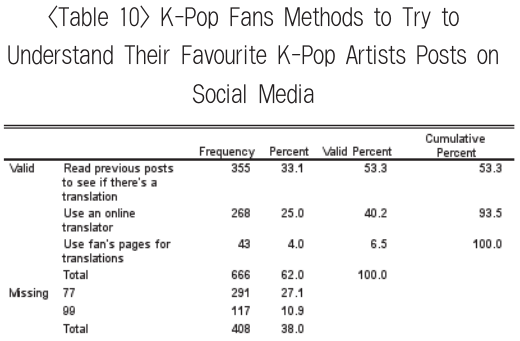
<Table 10> K-Pop Fans Methods to Try